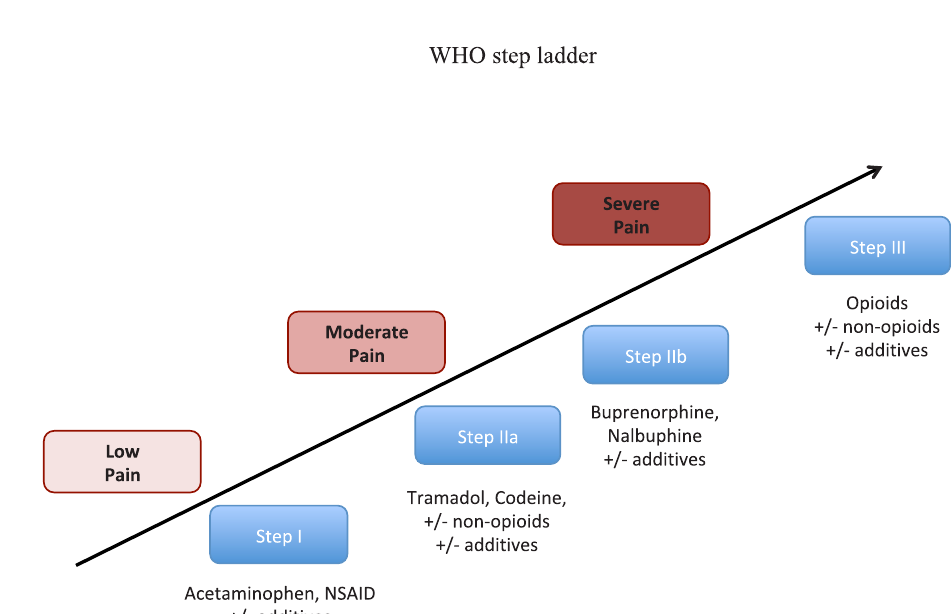
Fig. 2. Steps ladder for analgesic prescription according to the world health organization [4]. NSAID: Non-Steroidal Anti-In fl ammatory